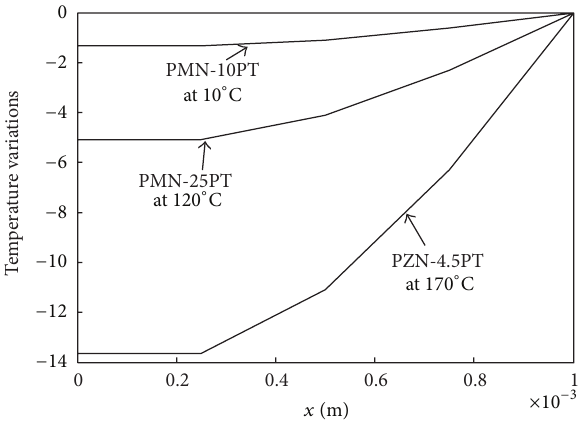
Figure 5: Temperature distribution along the sample length for PMN-10PT, PMN-25PT, and